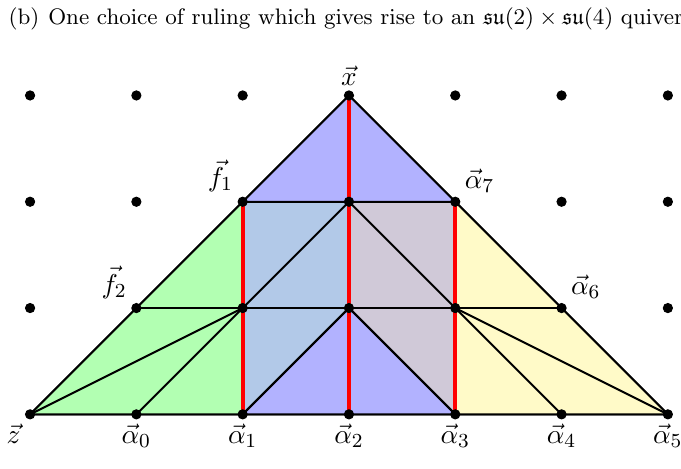
g has polygon bounded by ~ f 1